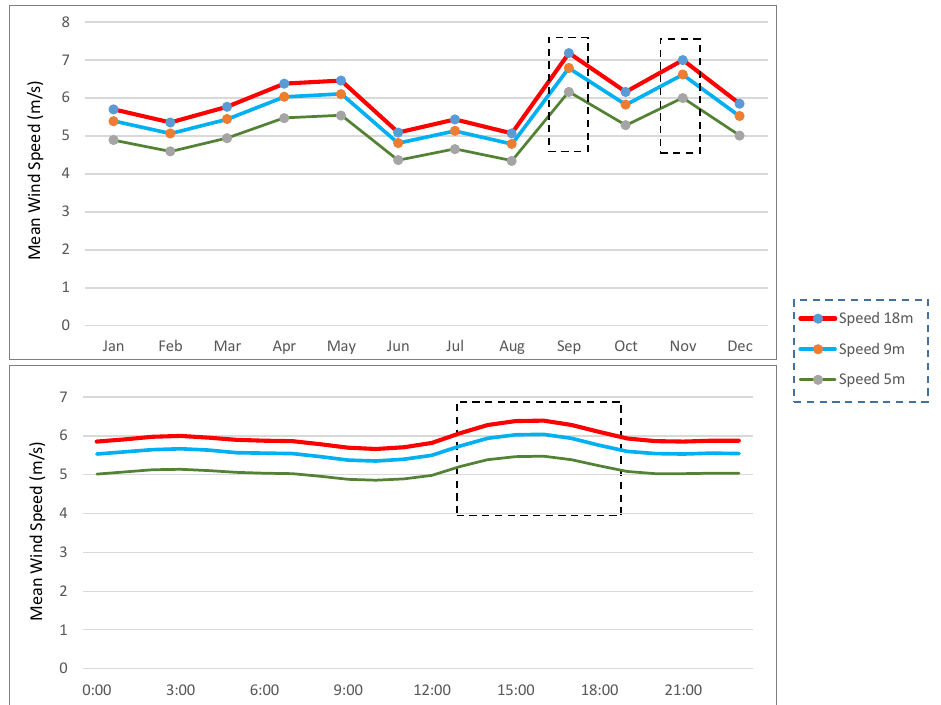
Figure 7. Seasonal and hourly analysis. Data layer: annual. Authors’ own elaboration.